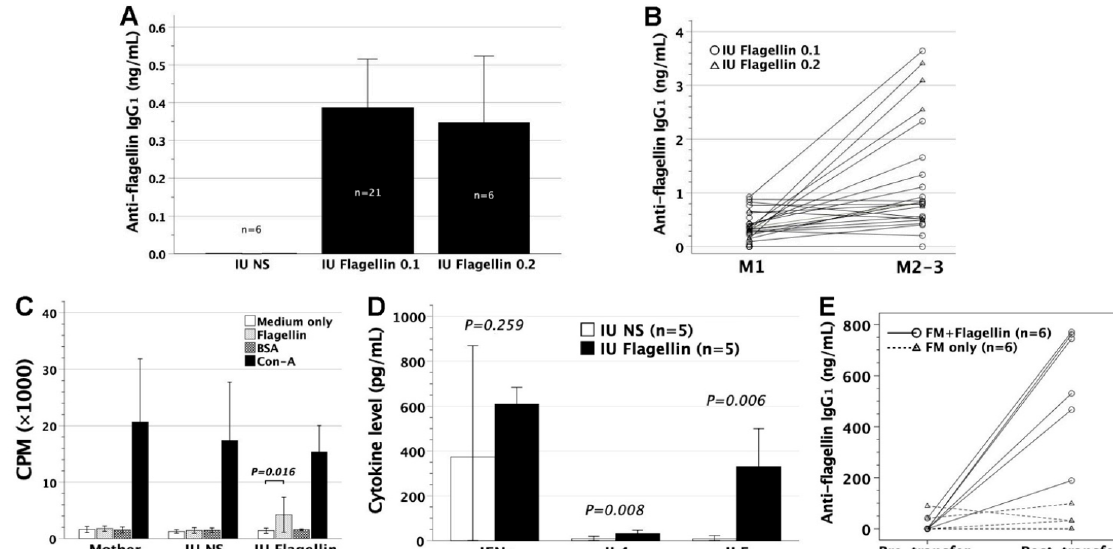
Figure 1. Immunological consequences after in utero injection of flagellin and adoptive transfer of flagellin-laden FMs. ( A ) FVB/N mice were subjected to in utero injection of 0.1 or 0.2 µ g endotoxin-free flagellin (IU Flagellin 0.1 and 0.2) at gestational day 14. At the age of about 1 month, mice were examined for serum anti-flagellin IgG 1 levels by ELISA using mouse monoclonal IgG 1 antibody (FLIC-1, BioLegend) as the standard curve. The controls were sera from mice with in utero injection of saline (IU NS). The IU Flagellin 0.1 and 0.2 groups significantly secreted anti-flagellin IgG 1 as opposed to the IU NS group ( p = 0.001 and 0.017, respectively). There was no difference in anti-flagellin IgG 1 levels between flagellin doses of 0.1 and 0.2 µ g ( p = 0.724). ( B ) Anti-flagellin IgG 1 , rechecked at the age of 2–3 months (M2–3), rose to a significantly higher level ( p = 0.001, paired t -test) than that at 1 month old (M1). ( C ) The splenic lymphocytes of recipients (n = 3 for each of IU Flagellin and IU NS) and mothers (n = 3) were examined for their proliferative responses to flagellin in culture systems by the readout of incorporated tritium as CPM. Medium only was used as a background control, BSA as a third-party stimulator, and Con-A as a mitogen to stimulate T-cell population. IU Flagellin exhibited proliferative responses specifically to flagellin stimulation (LSD following ANOVA), whereas IU NS and the mother were unresponsive. ( D ) Lymphocyte polarization was examined by IFN γ , IL4, and IL5 secretions in cell cultures under flagellin stimulation. IU Flagellin compared favorably in the levels of IL4 and IL5 but not IFN γ to IU NS, indicating a Th2-skewed phenotype. ( E ) Enriched FVB/N FMs were pulsed with flagellin overnight, and then intravenously injected into adult FVB/N mice (FM + Flagellin). Serum anti-flagellin IgG 1 levels before and after the cell transfer (4–6 weeks later) were measured by ELISA as described before. FM + Flagellin elicited significantly higher anti-flagellin IgG 1 ( p = 0.002, paired t -test) than the transfer of FMs maintained in media overnight (FM only, p = 0.752). Coupled circles or triangles represent paired pre- and post-transfer data from an individual mouse. FM, fetal macrophage; CPM, counts per minute; Con-A, concanavalin A; LSD, least significant